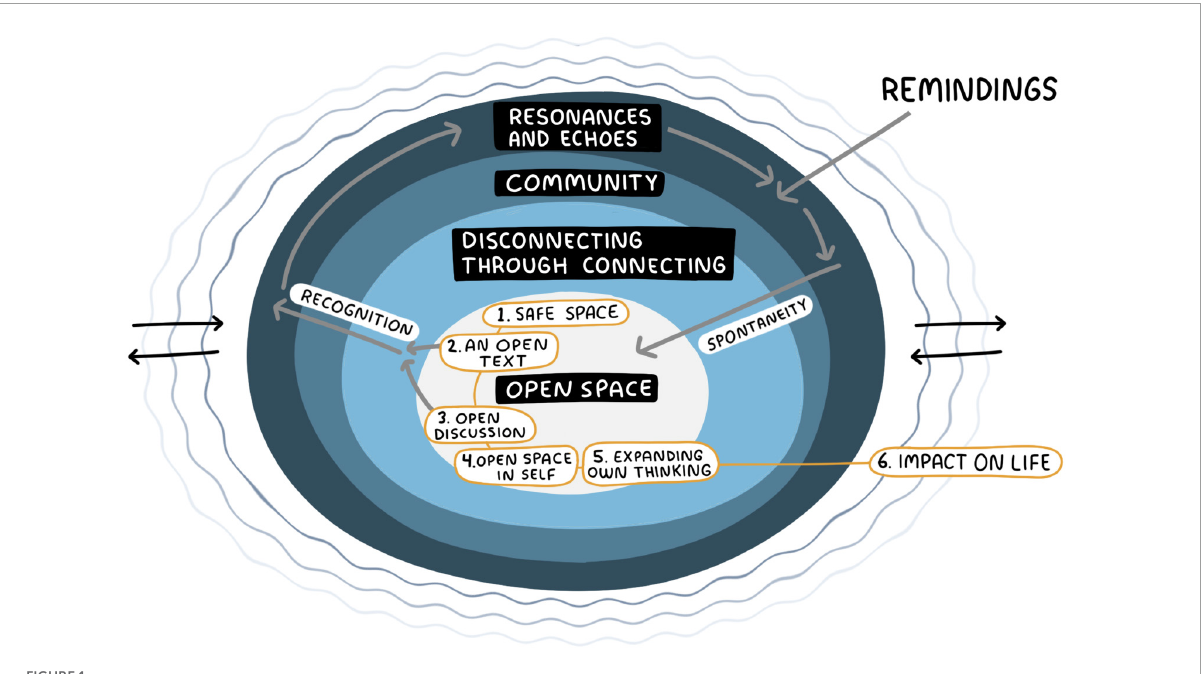
FIGURE1 Process model of Shared